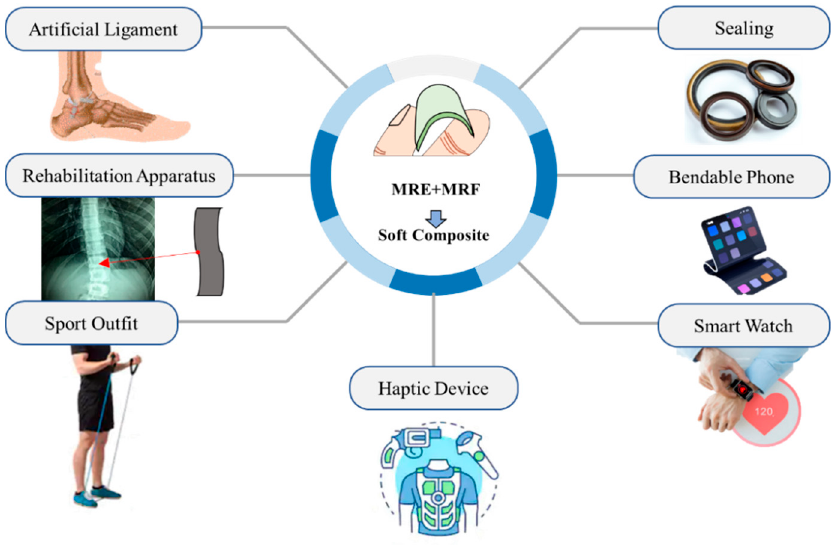
Figure 1. Various applications of soft composites fabricated from magnetic-responsive materials.